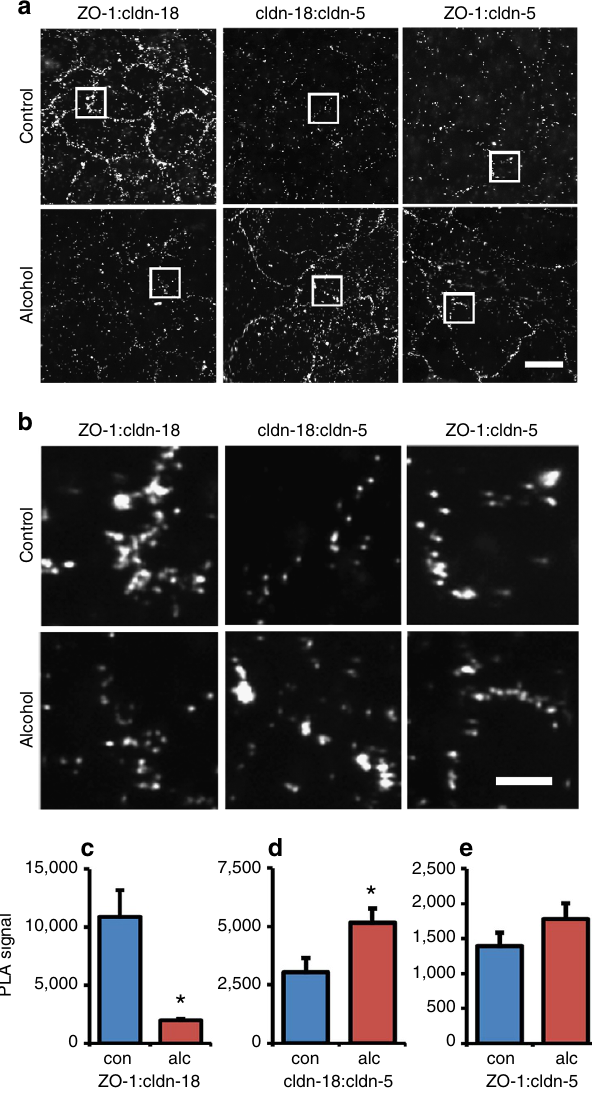
Figure 5 | Claudin-5 induced by alcohol decreases ZO-1:claudin-18 co-localization as determined by proximity ligation assay. ( a , b ) AECs isolated from alcohol (alc) or control (con) fed rats were cultured, immunolabeled and analyzed using the proximity ligation assay (PLA). Cells were PLA-labeled for claudin-18 and ZO-1, claudin-5 and claudin-18 or claudin-5 and ZO-1. Images in ( b ) are magnifications of regions in ( a ) as denoted by the squares. Bar, 20 m m. Negative controls are shown in Supplementary Fig. 10. Alcohol exposed AECs showed a reduction in the co-localization between claudin-18 and ZO-1 and an increase in co-localization between claudin-18 and claudin-5. Co-localization between claudin-5 and ZO-1 was comparable for both control and alcohol exposed cells. ( c – e ) Quantification of co-localization using PLA demonstrated a significant change. In alcohol-exposed AECs there was a significant decrease in ZO-1:claudin-18 ( n ¼ 6 fields,* P ¼ 0.018, unpaired two-tailed t -test) ( c ) which correlated with a significant increase in claudin-18:claudin-5 co-localization ( n ¼ 10 fields, * P ¼ 0.026, unpaired two-tailed t -test) ( d ). ZO-1:claudin-5 co-localization was unchanged ( n ¼ 6 fields, unpaired two-tailed t -test) ( e ). Data in ( c – e ) represent average ±